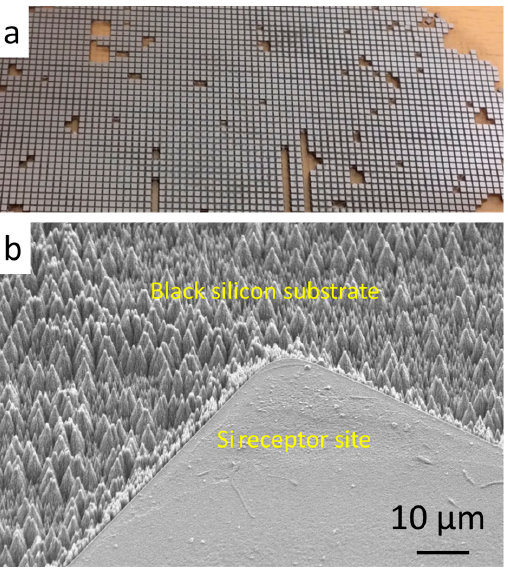
Figure 1. Silicon chips and fabricated receptor sites: ( a ) 500 μ m × 500 μ m × 300 μ m diced silicon chips; and ( b ) 500 μ m × 500 μ m hydrophilic Si receptor sites with superhydrophobic black silicon substrate.